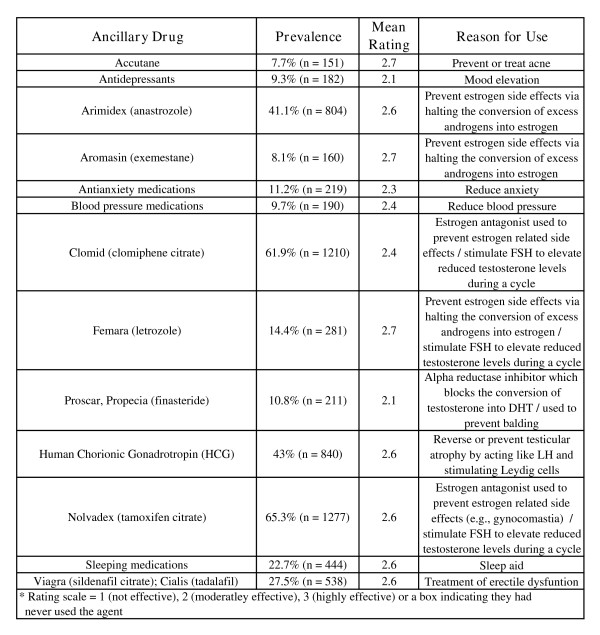
Ancillary Drugs.